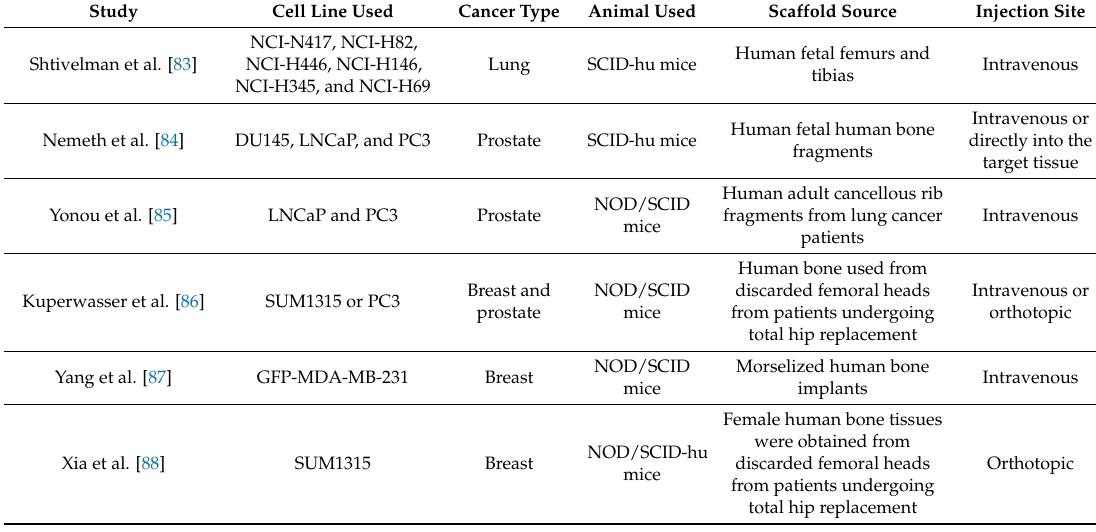
Table 4. Humanized models.